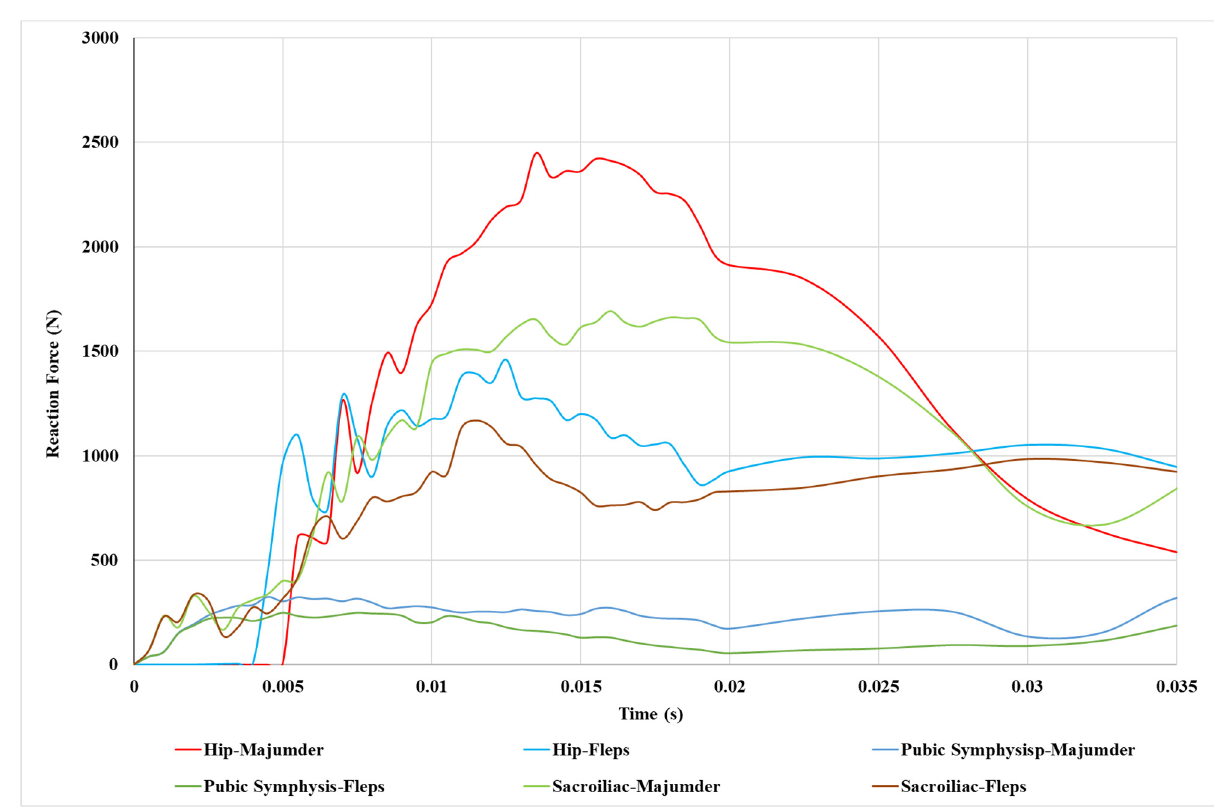
Figure A7. Stress–strain response of various experimental and computational models for the trochanteric soft tissue.